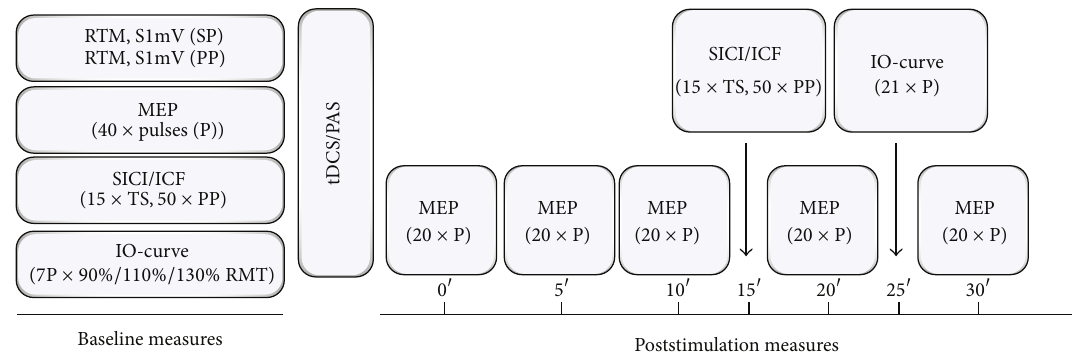
Figure 1: Experimental course and design. At baseline RMT and S1mV were recorded for single-pulse (SP) and paired-pulse (PP) TMS- measures. Then, 40 MEP with test stimulus intensity pulses (P), SICI and ICF (15 test stimuli and 10 paired stimuli for each ISI), and IO-curves were obtained followed by either anodal tDCS or PAS. After stimulation 20 MEP were recorded at five different time points for 30 minutes with SICI/ICF and IO-curves measured at 15 and 25